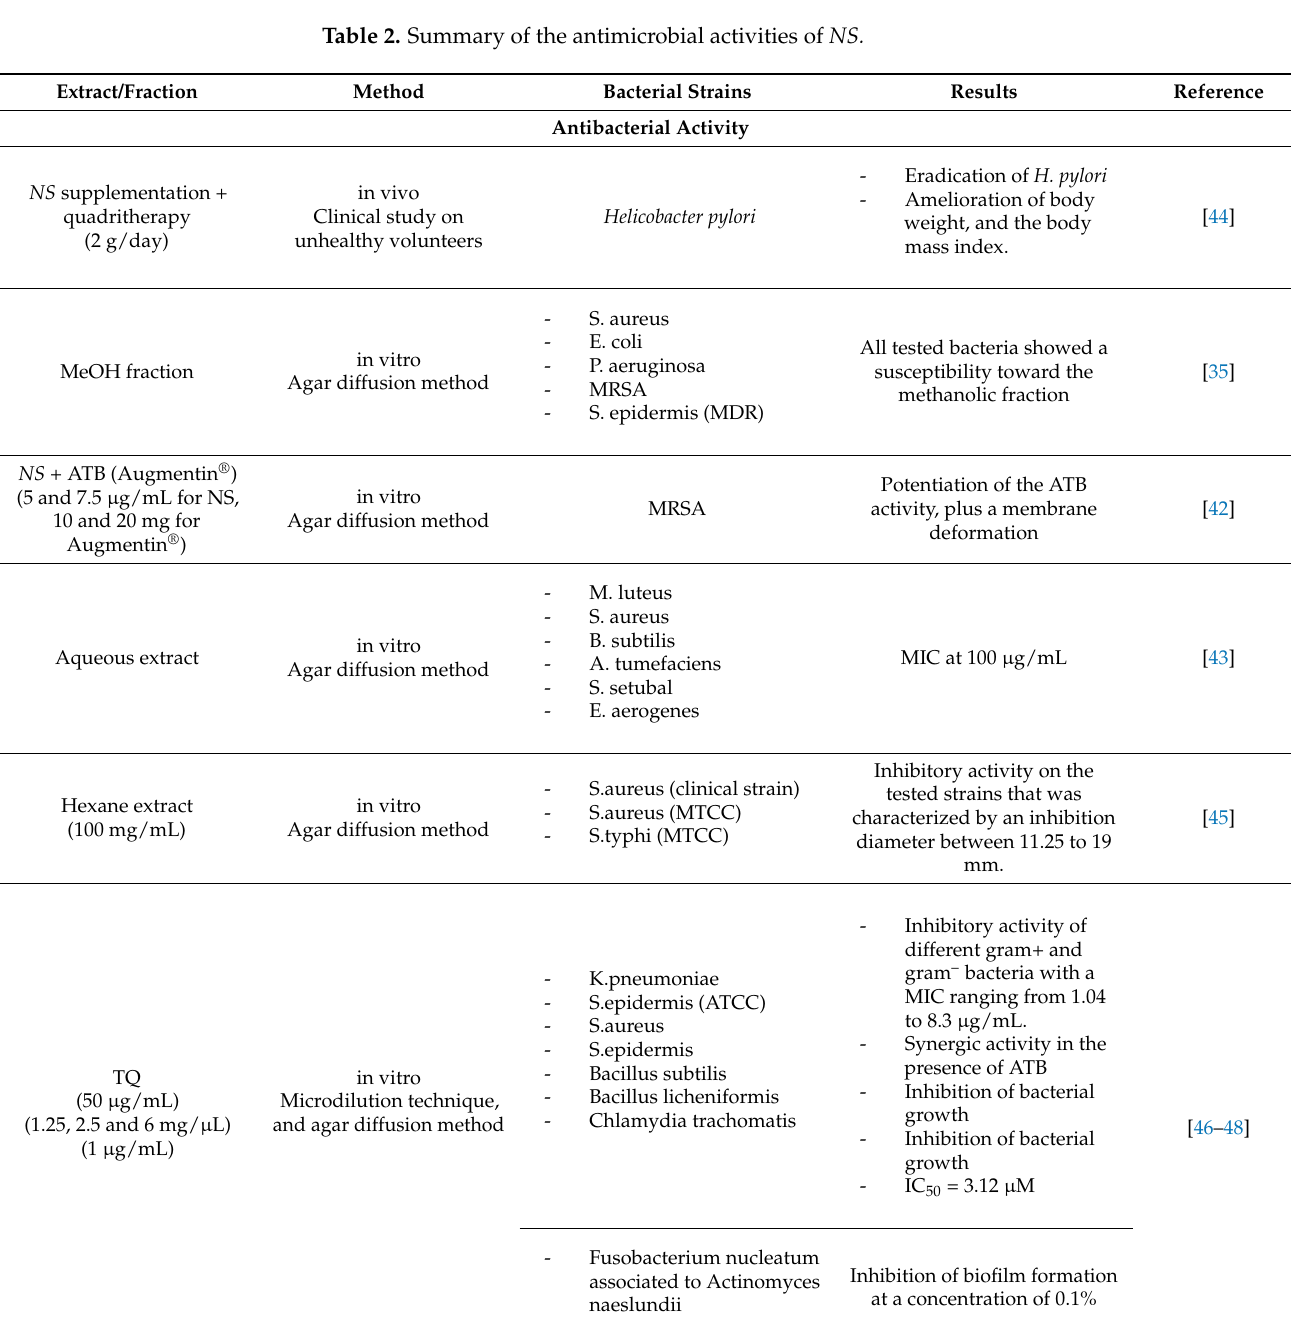
Table 2. Summary of the antimicrobial activities of